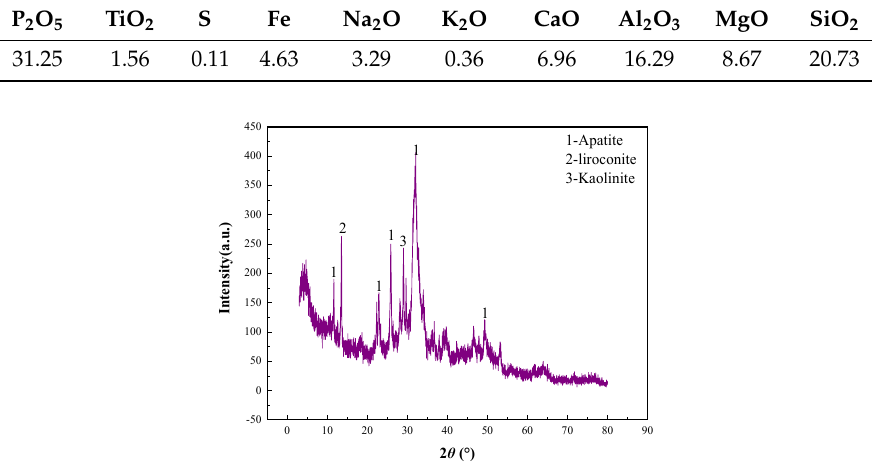
Figure 13. XRD di ff ractograms of the P–Containing V–Ti magnetite Figure 13. XRD diffractograms of the P–Containing V–Ti magnetite tailings.